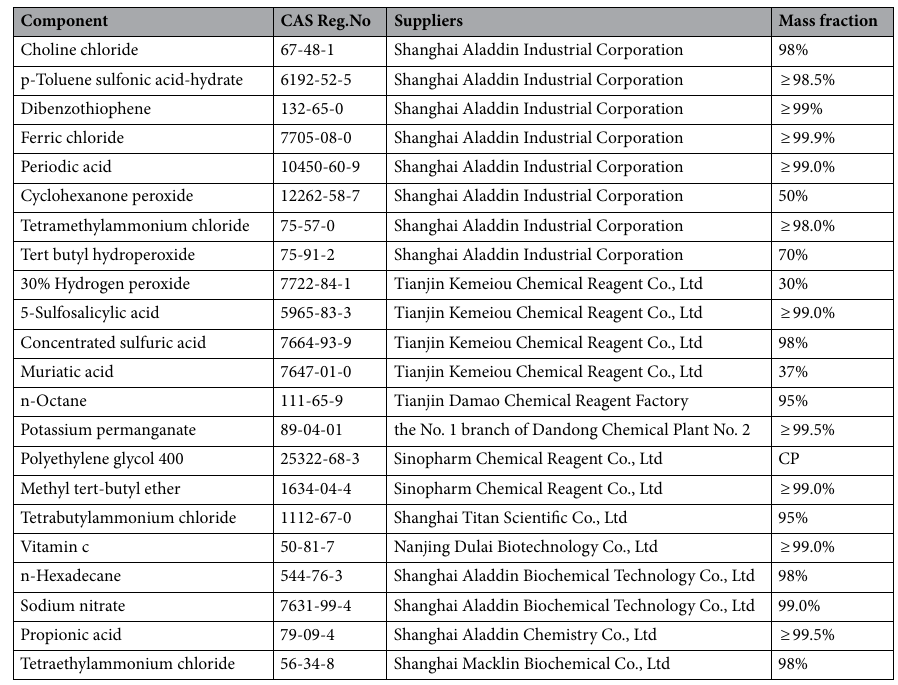
Table 1. CAS registry number, mass fraction of the chemicals.